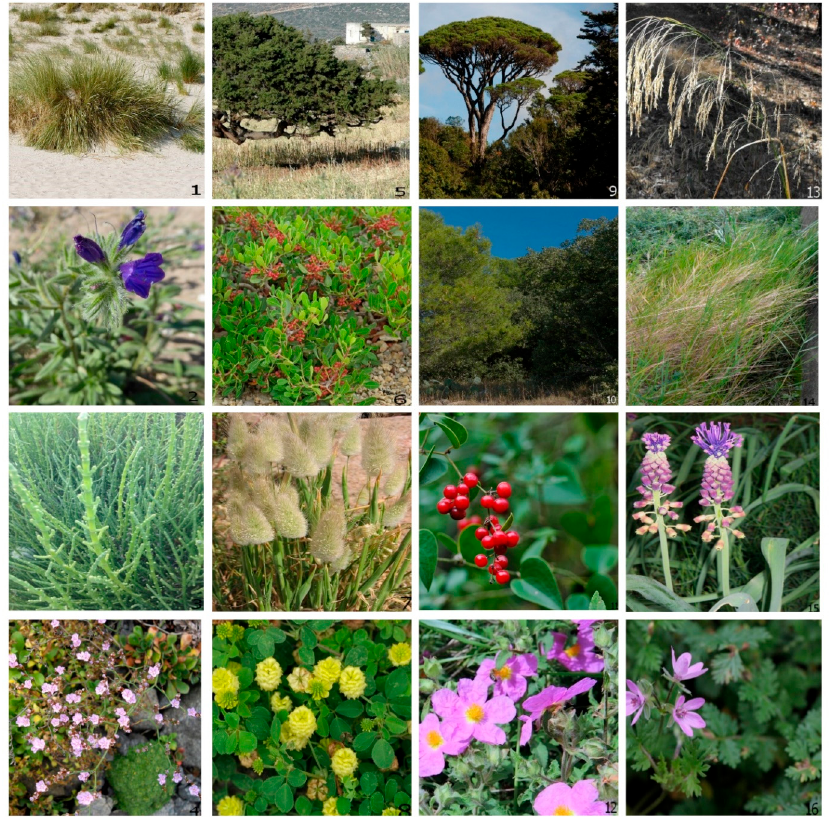
Figure A2. Brief photos of important plants and their habitats at Schinias: 1. Elymus farctus , 2. Echium arenarium , 3. Salicornia fruticose , 4. Limonium bellidifolium , 5. Juniperus phoenicea , 6. Pistacia lentiscus , 7. Lagurus ovatus , 8. Trifolium campestre , 9. Pinus pinea , 10. Pinus halepensis , 11. Smilax aspera , 12. Cistus criticus , 13. Piptatherum miliaceum , 14. Brachypodium retusum , 15. Muscari commosum , and 16. Erodium cicutarium (photo credit: A. solomou